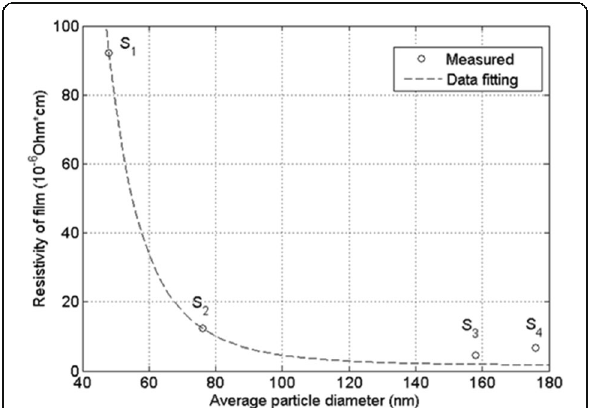
Fig. 5 The relationship between the resistivities of the Ag NP-based films and the mean diameter of the Ag NPs at heat temperature of 140 °C. The dashed line is the curve of numerical fitting using Eq.